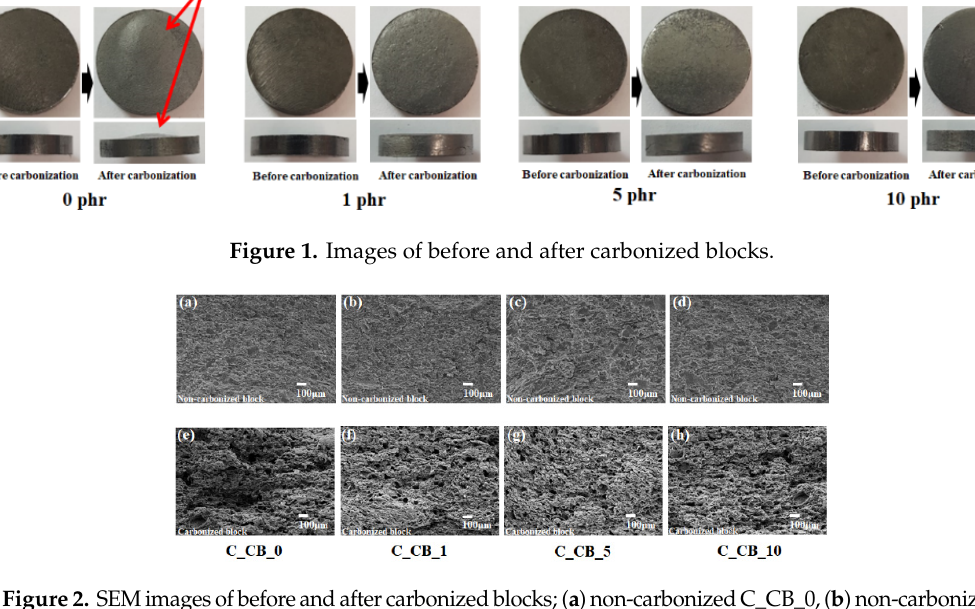
Figure 2. SEM images of before and after carbonized blocks; ( a ) non-carbonized C_CB_0, ( b ) non- carbonized C_CB_1, ( c ) non-carbonized C_CB_5, ( d ) non-carbonized C_CB_10, ( e ) carbonized C_CB_0, ( f ) carbonized C_CB_1, ( g ) carbonized C_CB_5, and ( h ) carbonized C_CB_10.